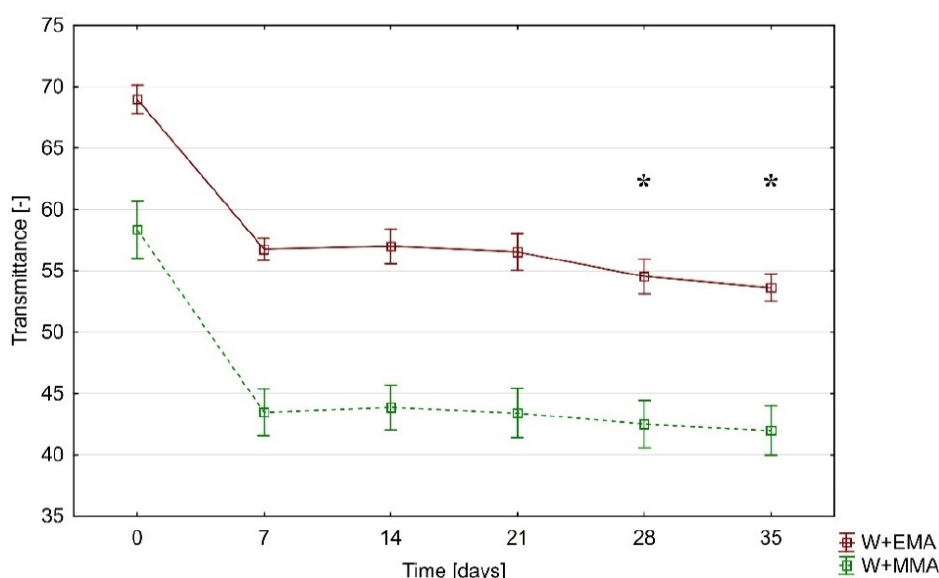
Figure 5. Change of transmittance during the experiment * denoted exposure time of W+EMA at which the total colour differences was statistically significant (in interval from 7 to 35 days) based on results of Duncan’s test (difference between 0 days of exposure and other exposure times is obvious without statistical test).